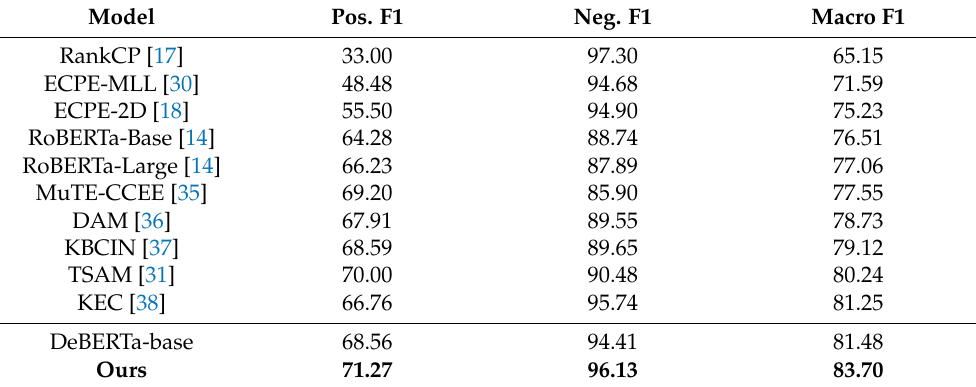
Table 3. Overall results of emotion–cause pair extraction model.